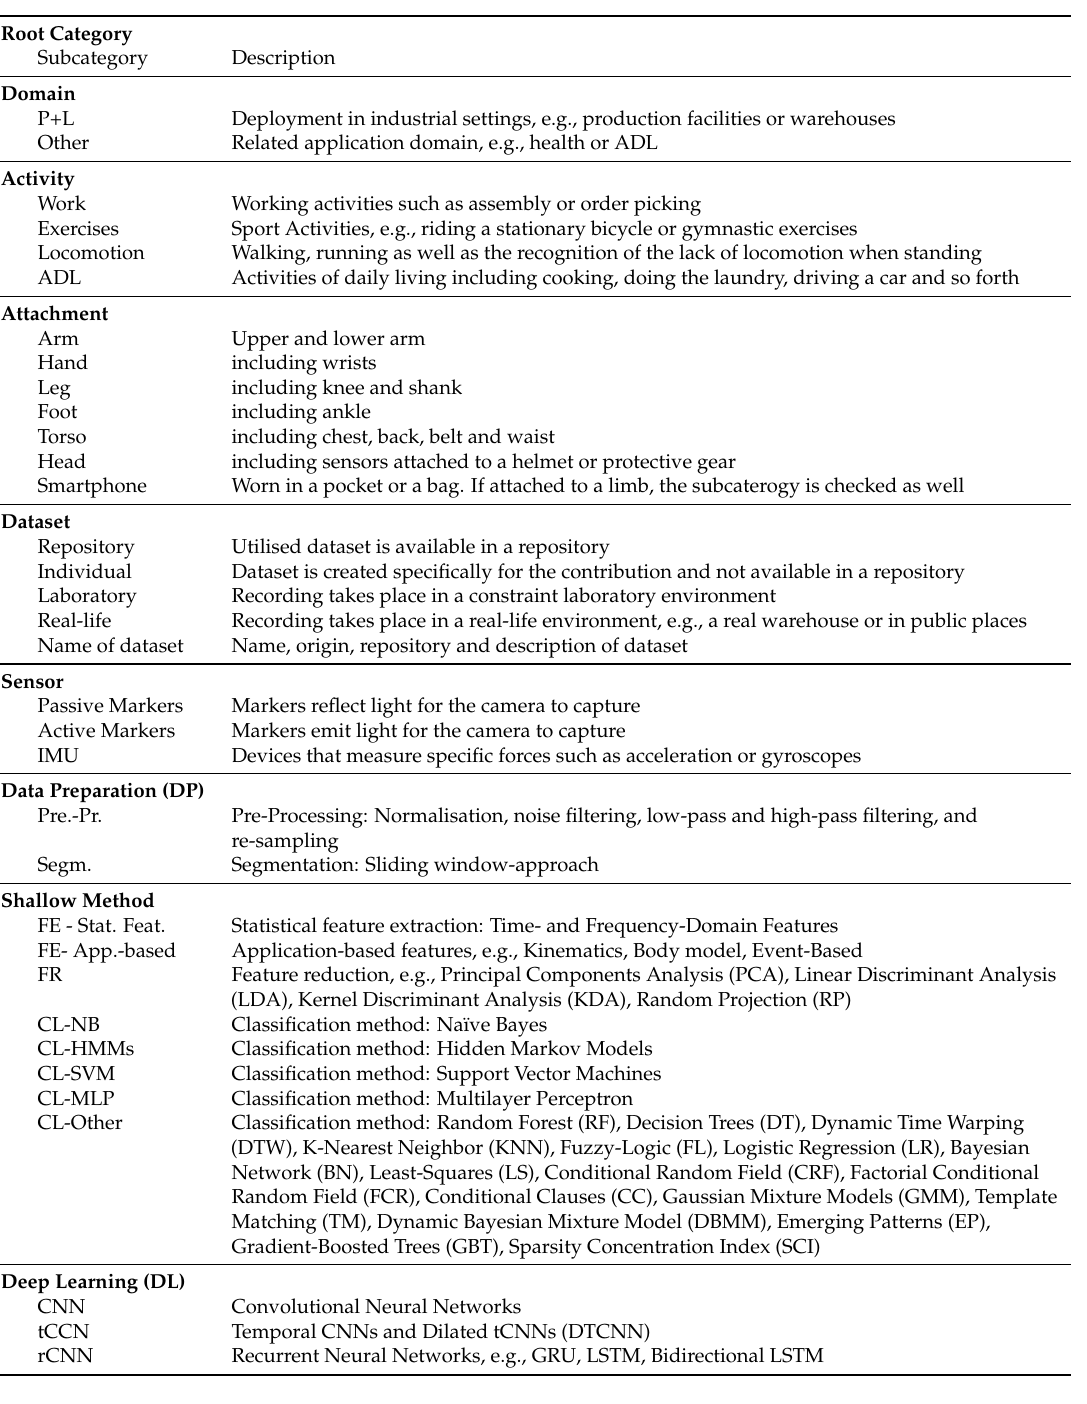
Table 5. Categorisation